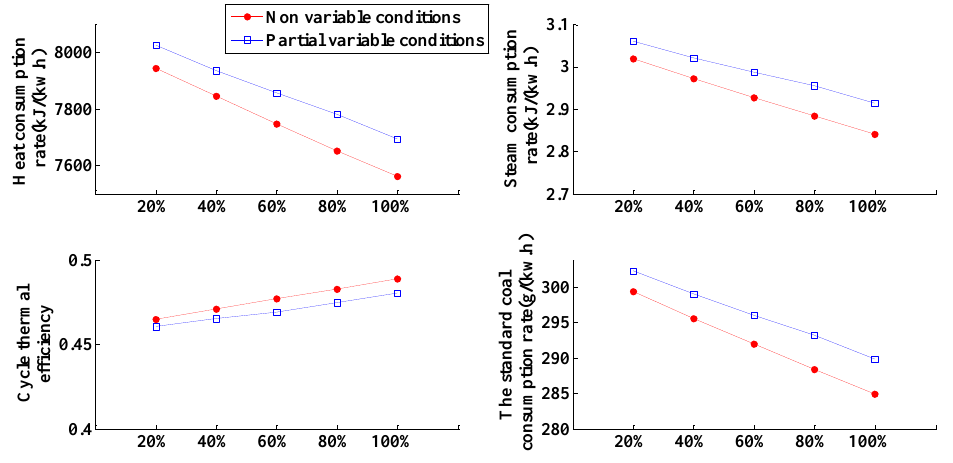
Figure 10. SAPG system 1st thermal economy.